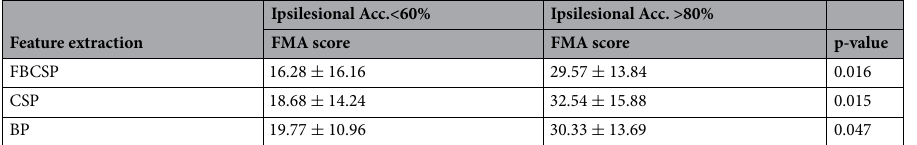
Table 4. Comparison of the Fugl-Meyer scores between those with the ipsilesional BCI accuracy below 60% and those with the ipsilesional BCI accuracy over 80%, obtained using three different BCI feature extraction methods. FMA Fugl–Meyer assessment, Acc.